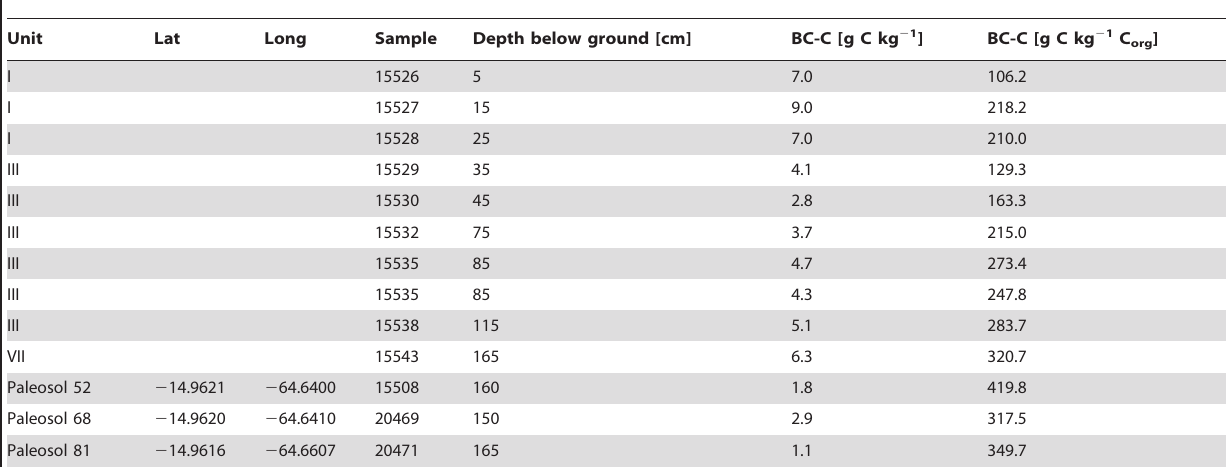
Table 2. Amount of black carbon (BC) in SM1 and in the surrounding paleosol.